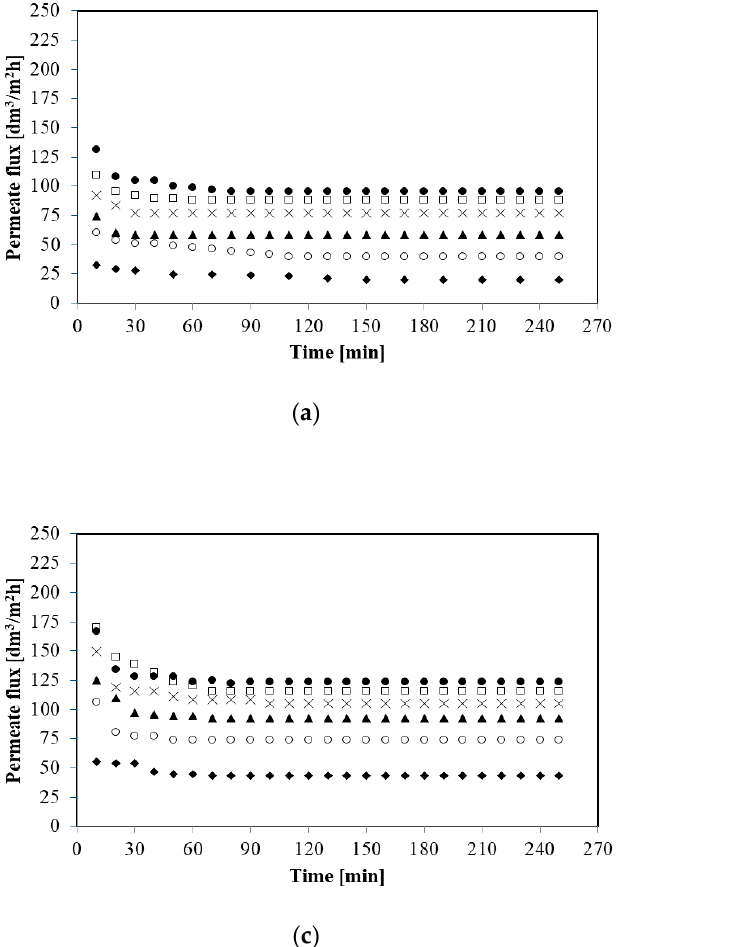
0.04, (cid:78) 0.06, (cid:35)